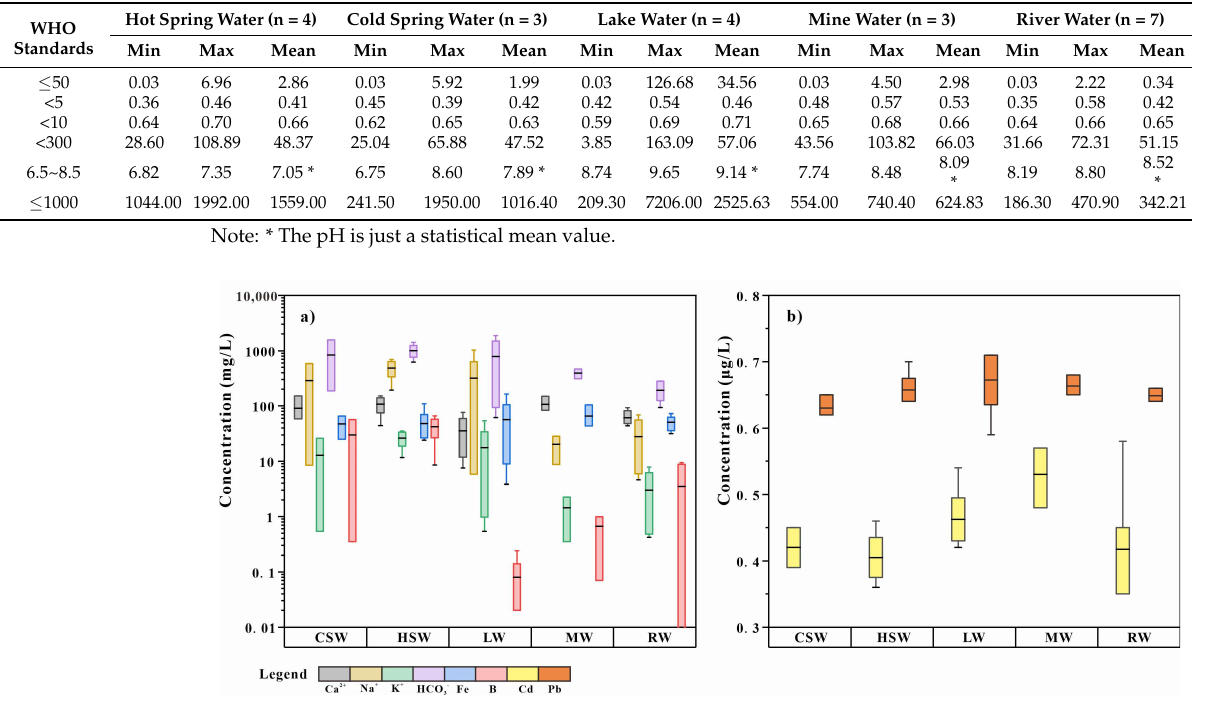
Figure 2. Box plots of chemical parameters for different water types in the study area.